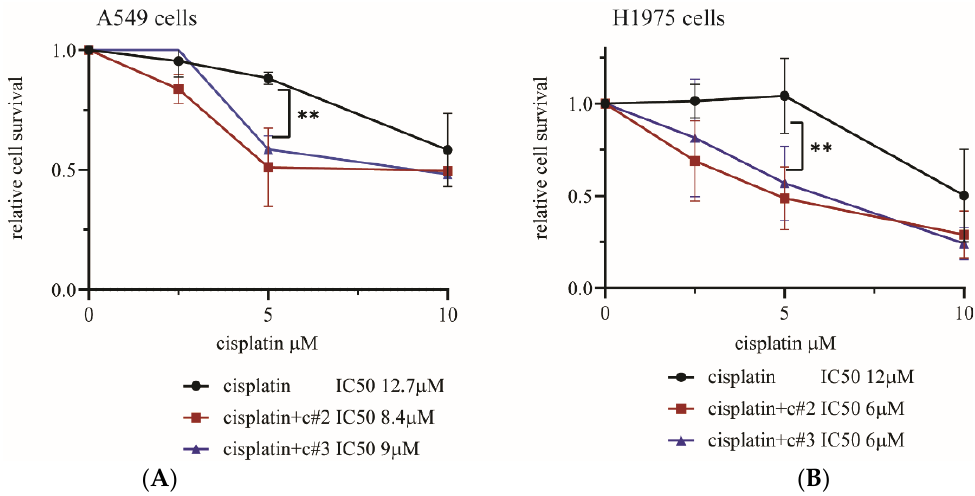
Figure 3. Compounds #2 and #3 sensitize cells to cisplatin treatment. ( A ) Colony survival assay of A549 cell line. ( B ) Colony survival assay of H1975 cell line. Both cell lines were treated with 50 μ M of compound and the indicated concentration of cisplatin for 48 h; then, growth media was replaced with normal growth media with no compound. Cells were allowed to recover 4–5 days before staining. For both cell lines, colony survival assay n = 3 independent experiments, SD = 1, error bars represent 1 SD . p- value < 0.01 (**)was calculated by two-way ANOVA multiple comparisons. IC50 was calculated using linear regression. A representative colony survival assay is presented in Figure S1C.